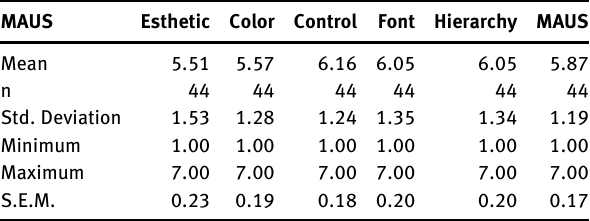
Table  : MAUS descriptive analysis results.